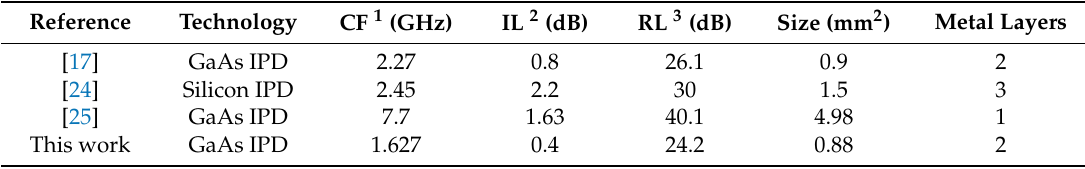
Table 1. Performance Comparison with Reported